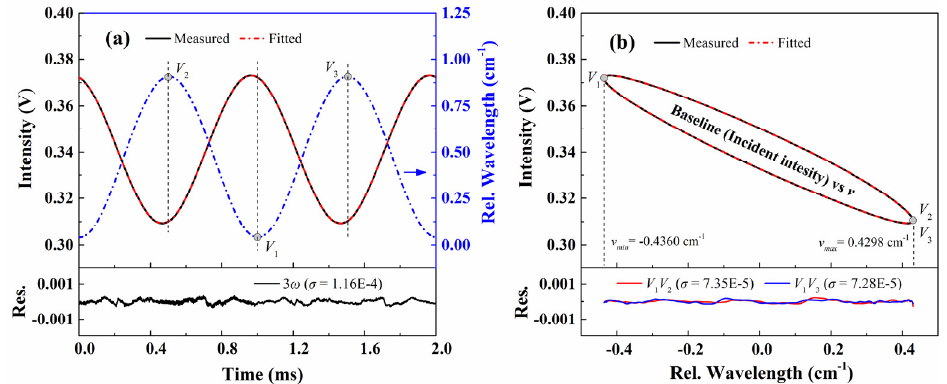
Figure 6. ( a ) Detected baseline versus time and its best-fit with Equation (10); ( b ) recovered baseline versus wavelength form WM-DAS and its best-fit with Equation (13). The experimental conditions are: pure N 2 , T = 299 K, L = 14.7 cm, P = 101.3 kPa.